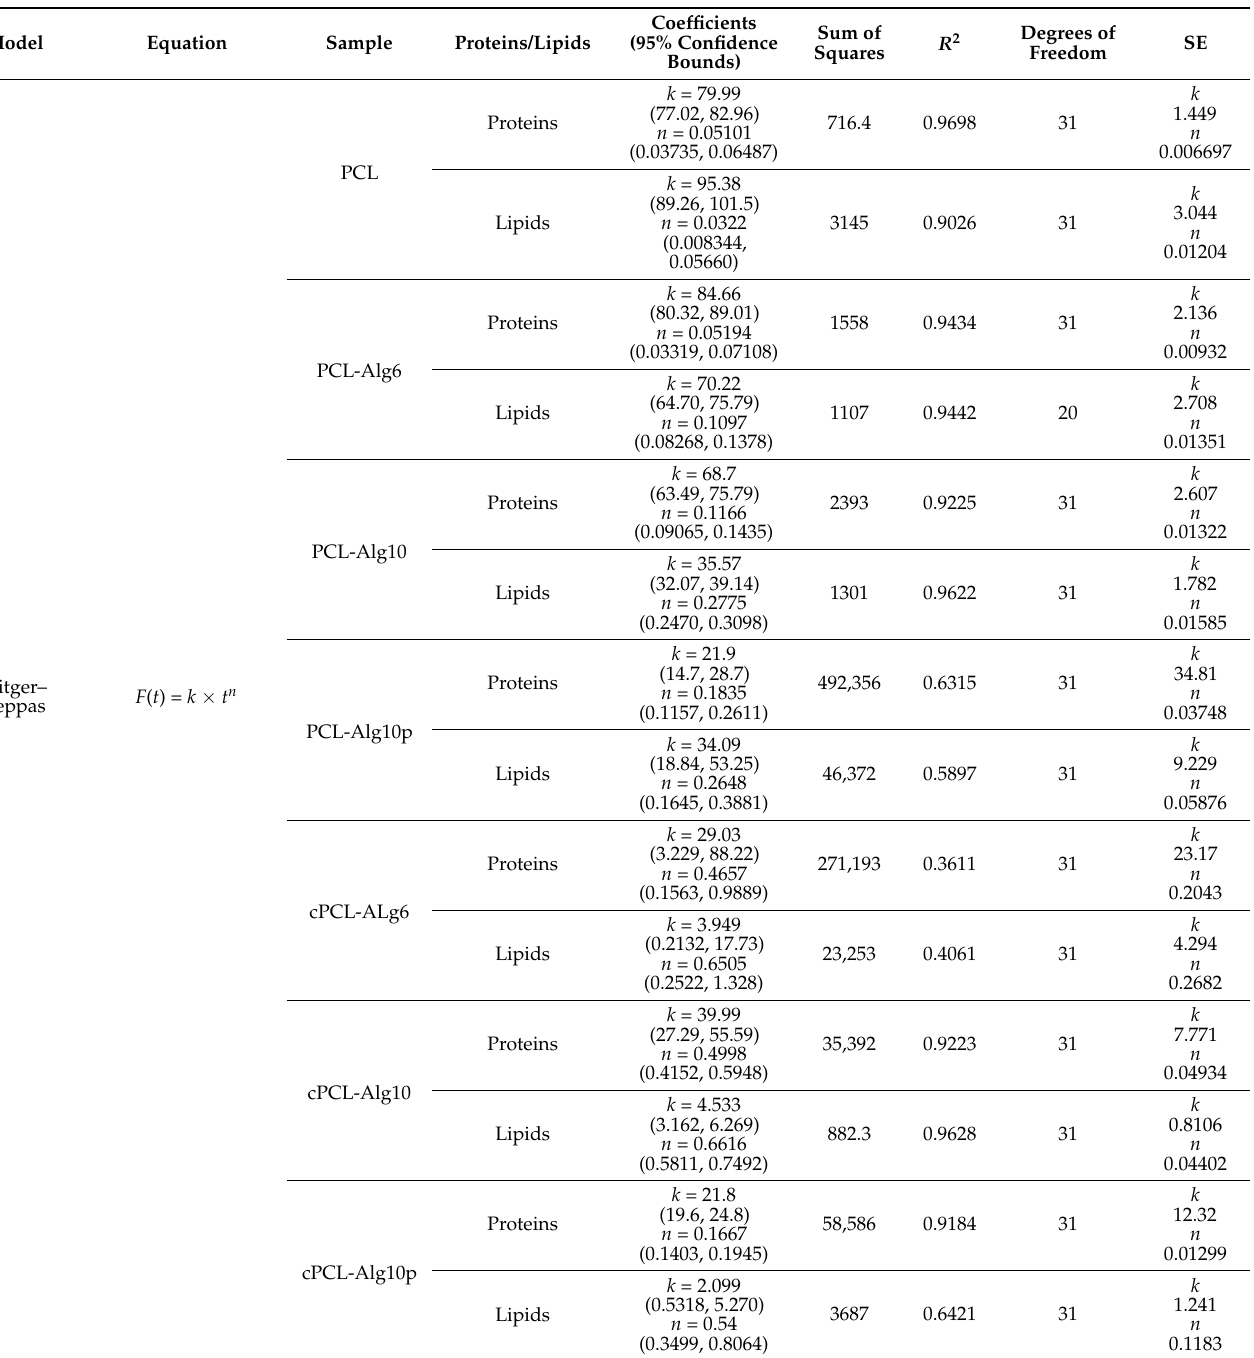
Table 6. Results of in vitro release model fitting for PCL, PCL-Alg6, PCL-Alg10, PCL-Alg10p, cPCL-Alg6, cPCL-Alg10, and cPCL-Alg10p. Kinetic elaborations were performed on release data obtained from at least three independent experiments for each batch. ~ indicates that the analysis performed was “ambiguous”; therefore, the fit does not nail down the values of all the parameters, and 95% confidence bounds cannot be reported. These latter data were not considered in the interpretation of